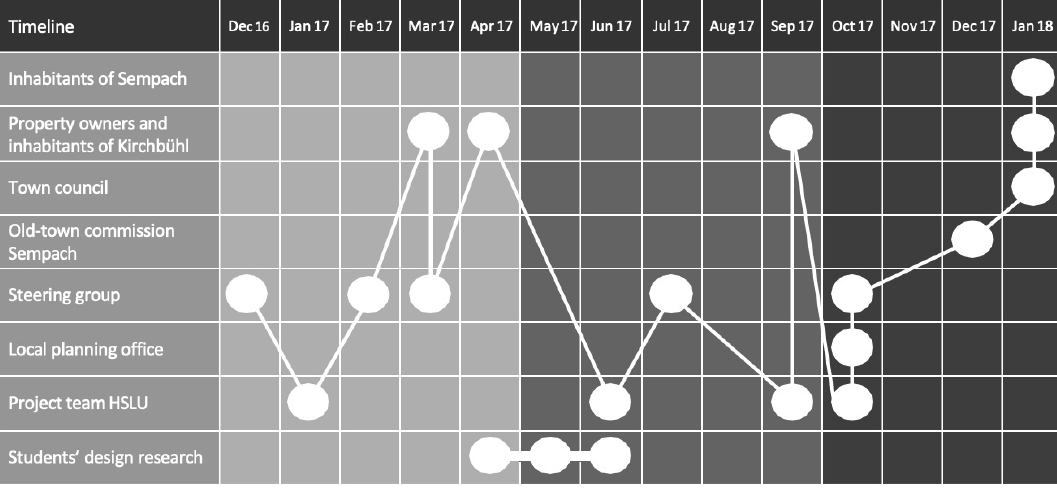
Figure 16: Summarising graph of the project process and steps Source: